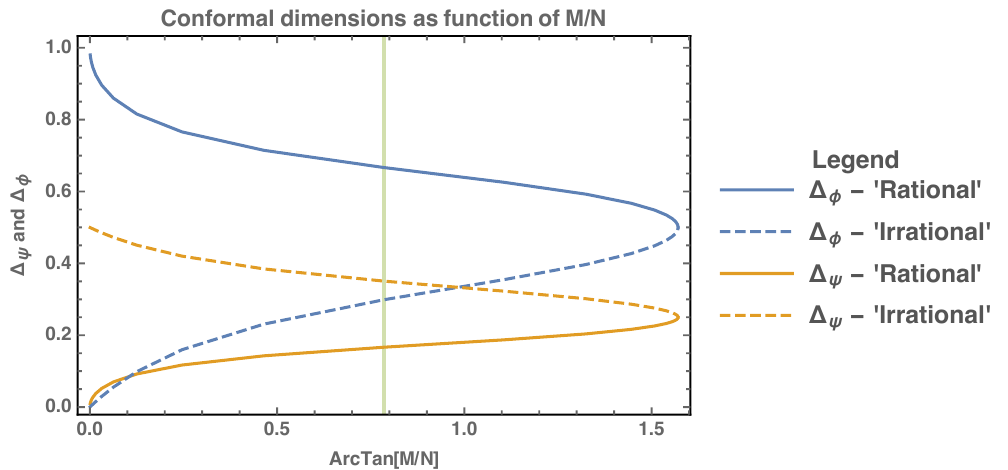
Figure 3. This (cid:12)gure shows the conformal dimensions as a function of M=N . The two solutions are labelled by their (ir)rational behaviour at M = N (which may di(cid:11)er for other values), see eq. (3.20) and eq. (3.21). The green line represents this point where M=N =